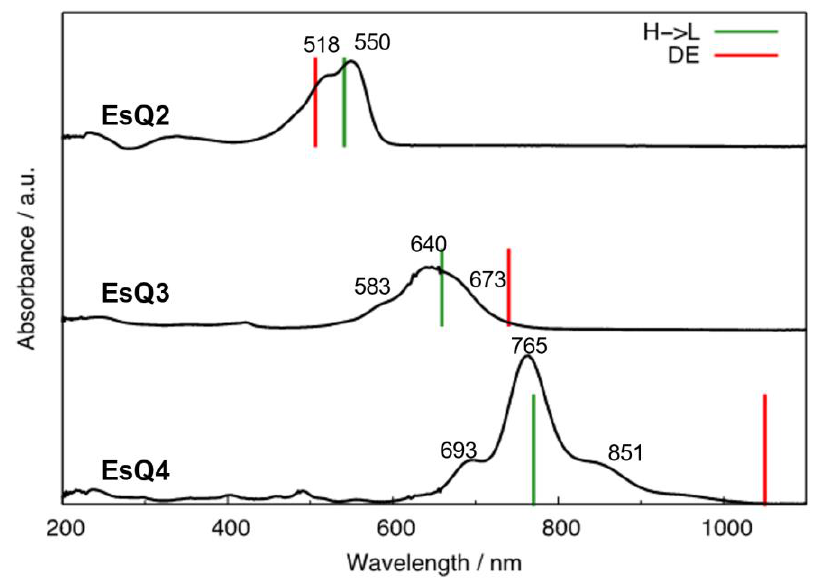
Figure 4. Comparison between UV-Vis-NIR electronic absorption spectra of cyano-ester quinoidal oligothiophenes in dichloromethane (solid black lines and black numbers) and DFT-MRCI computed excitation energies for the bright HOMO → LUMO (green bars) and the DE (red bars) electronic states.